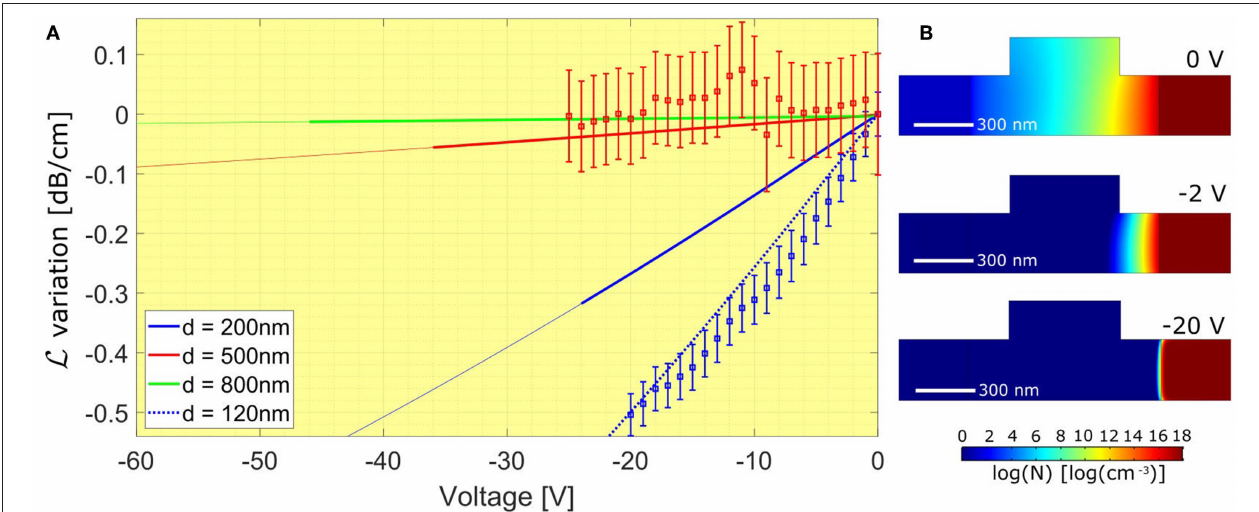
FIGURE 5 | (A) Experimental (points) and simulated (solid lines) variation of the loss coefficient L as a function of the applied bias voltage for d = 200 nm , d = 500 nm and d = 800 nm . In the case d = 800 nm the experimental values are not shown for clarity, because they are very similar to those for d = 500 nm . The dotted line refers to d = 120 nm . (B) Simulated electron concentration inside the waveguide for d = 200 nm and different values of the applied bias